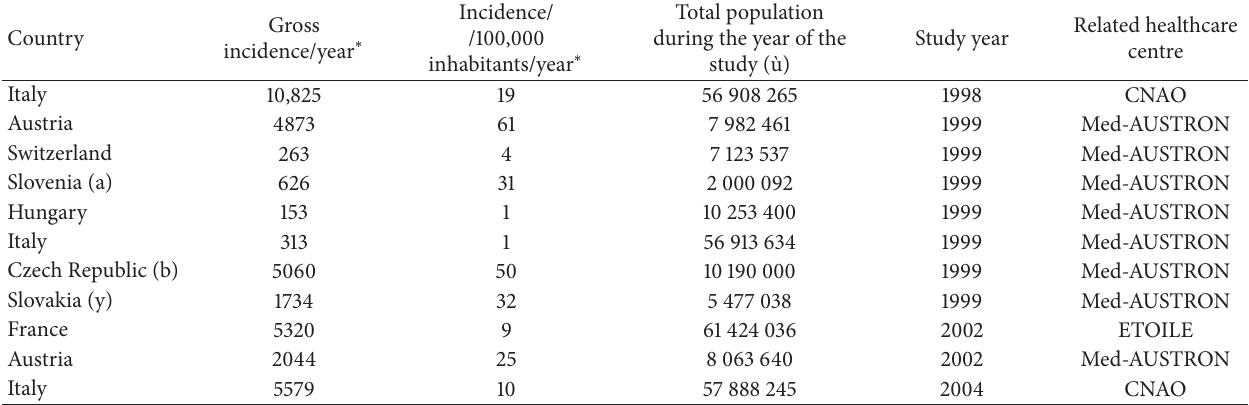
∗ Estimate expressed in study population, irrespective of disease